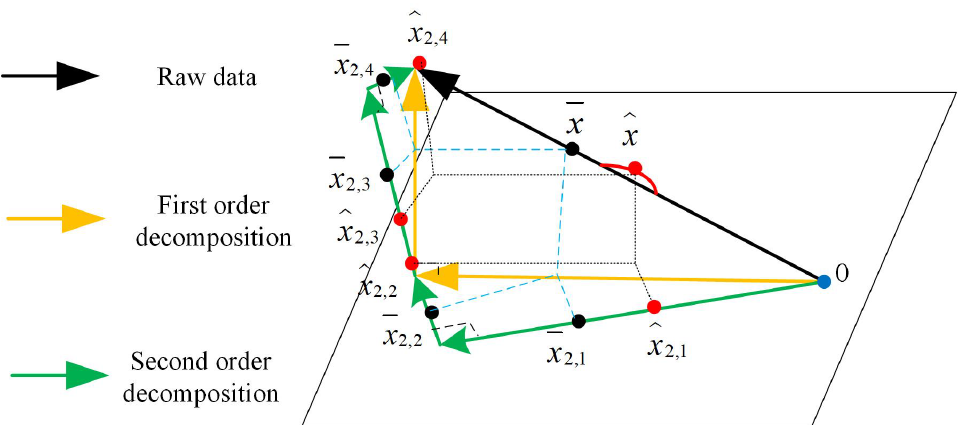
Figure 6. Geometric description of fault detectability analysis based on Deep PCA